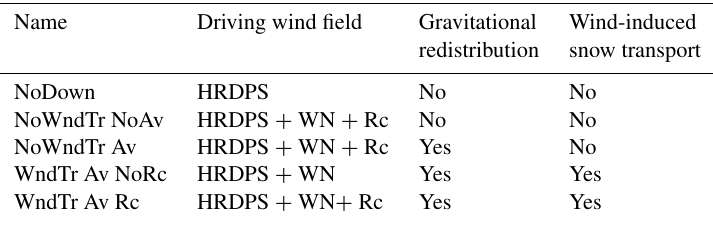
Table 2. CHM simulations (experiments) used in this study. Rc indicates CHM simulations using wind fields from the downscaling method accounting for wind speed reduction in leeward areas. HRDPS refers to the High Resolution Deterministic Prediction System and WN to WindNinja. See text for more details.